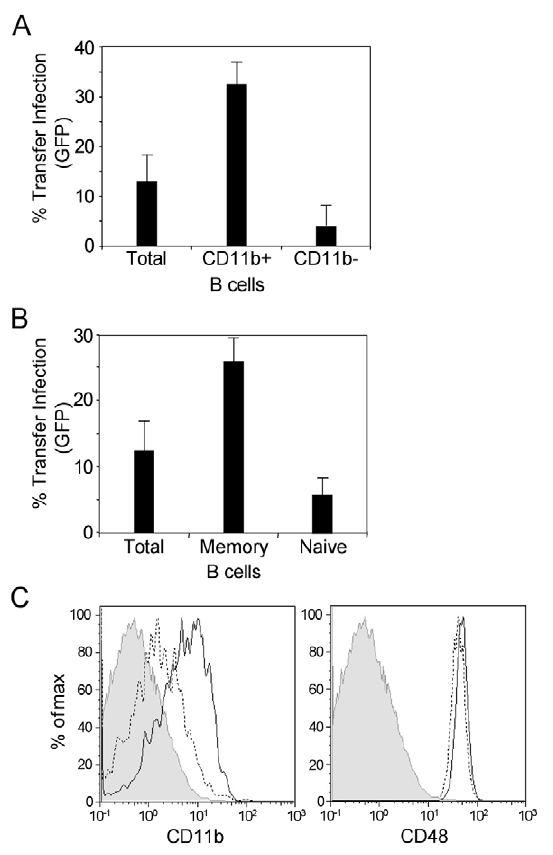
Figure 9. Transfer infection via the basolateral surface is mediated via memory B cells. (A) Total B cells, CD11b + ve and CD11b -ve B cells were sorted and infected with EBV (24 h p.i.) and co- cultured at the basolateral surface of polarized primary tonsillar epithelial cells for 1 hour. The B cells were washed off and the epithelial cells monitored for infection by flow cytometric analysis of GFP expression after 24 hours. Infection was plotted as the mean of triplicates. (B) Total B cells, memory B cells and naı¨ve B cells were sorted, infected with EBV, and co-cultured with the polarized epithelial cells as above. Infection was monitored by flow cytometric analysis of GFP expression and plotted as the mean of triplicates. (C) Flow cytometric analysis of naı¨ve and memory B cell expression of CD11b and CD48. Total B cells were stained with CD27 and IgD plus CD11b or CD48. The shaded area represents the isotype control; the dotted line represents the naı ¨ ve B cells (IgD + CD27 2 ); the solid line represents the memory B cells (IgD 2 CD27 + ).